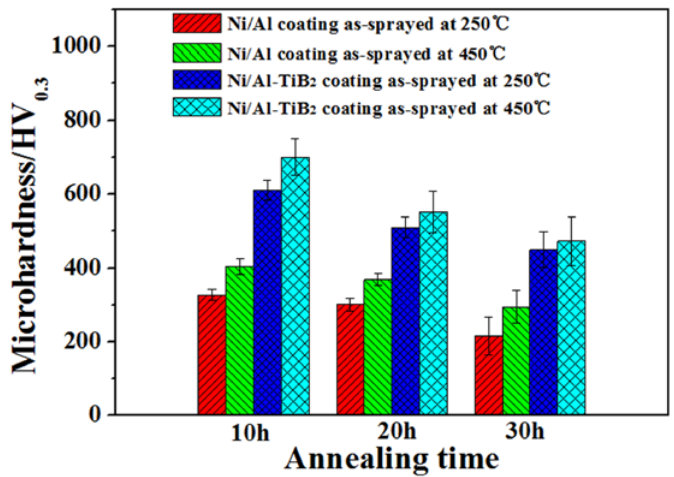
Figure 20. The microhardness of the annealed Ni/Al coatings and Ni/Al-TiB 2 coatings at different annealing times. annealing